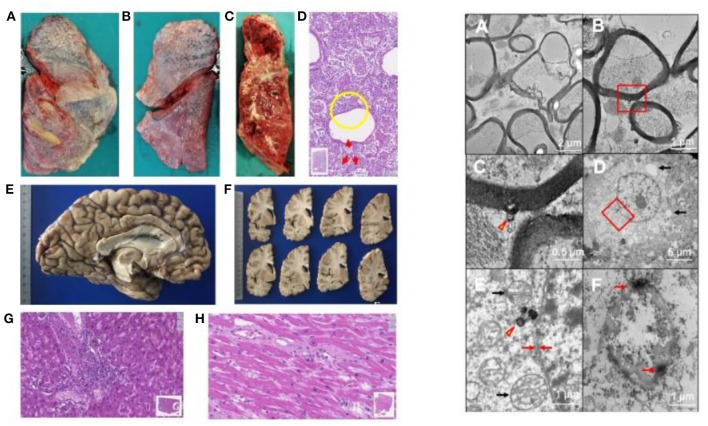
LEFT. Autopsy findings in Covid-19 positive patients. Patients who died underwent autopsy 2–3 h after death, ascertained by a continuous 20-min electrocardiographic recording. (A–C) Lung findings at autopsy. Gross autopsy examination shows that the lungs have increased consistency but reduced volume. The lung parenchyma on the cut surface appears dry: squeezing produces scarce aerated blood. The lung parenchyma varies in color from bright red to grayish, with hemorrhagic areas of various sizes [(A) right lung, outer surface. (B) Left lung: external surface. (C) Left lung: cut surface of the parenchyma]. (D) Histologically, the lung alveolar cavities display abundant cellularity and fibrin aggregates (one in the yellow circle). The red arrows indicate in areas surrounding the bronchiolar walls amorphous material suggesting hyaline pulmonary membranes (E-E; 11.5x magnification; Hamamatsu NanoZoomer digital slide). (E,F) Left cerebral hemisphere without macroscopically evident pathological alterations. (G) Liver. The image highlights a portal septum with marked inflammatory infiltration. Inflammatory cells attack the adjacent hepatocyte plate and can also be seen within the sinusoidal spaces. The liver image also shows changes indicating biliary stasis (E-E; 19.3x magnification; Hamamatsu NanoZoomer digital slide). (H) Left ventricular myocardium. The gap between the myocytes contains mild but widespread inflammatory infiltration (E-E; 33.5x; Hamamatsu NanoZoomer digital slide). Right: Involvement of the nervous system in SARS-CoV-2 infection on transmission electronic microscopy. Ultrastructure in the medulla oblongata (A–C); gyrus rectus (D,E); and olfactory nerve (F). (A) Marked axonal damage involving the medulla oblongata, with irregular axonal swelling and disordered myelin sheath. The damage appears widespread. (B) A viral particle (red box) is observed in the periaxonal matrix near the outer surface of a myelin sheath. (C) Magnification of the red box area in (B) the spherical particle (~98 nm) has a crown shape with a dense inner core and electron-dense periphery with small external projections. The center of the particle contains a small roundish electron-dense structure compatible with that of SARS-CoV-2. (D) The image shows a neuron in the gyrus rectus, as demonstrated also by a nucleolus in the center of the euchromatic nucleus; autophagy phenomena in the cytoplasm (arrows) suggest cell damage. (E) Magnification of the red box area in (D), showing a viral-like particle measuring 160 nm (arrowhead). Black arrows indicate two well preserved mitochondria; the red arrows show the neuron's typical double nuclear envelope. The well-preserved ultrastructural features of these organelles demonstrate adequate collection and fixation methods and suggest that the tissue damage is related to the viral infection. (F) Severe tissue damage in the olfactory nerve: the oval structure is difficult to identify and is characterized by extensive autophagy phenomena with markedly electron-dense peripheral aggregates (arrows) (Images by Unitech NO LIMITS).